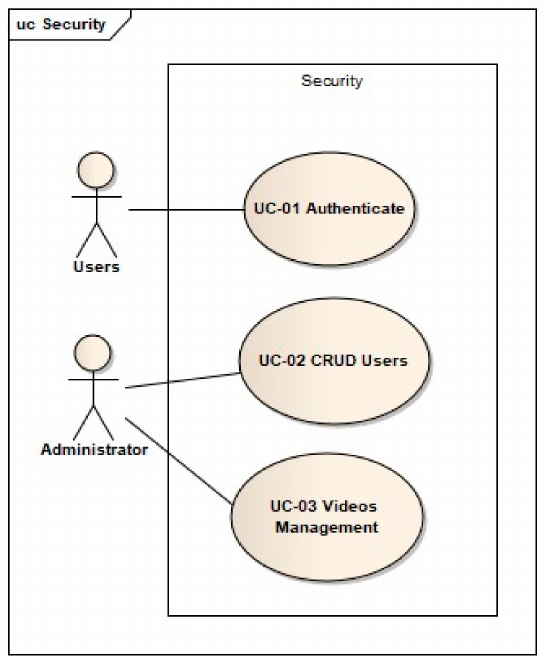
Figure 3. Security use case (UC)